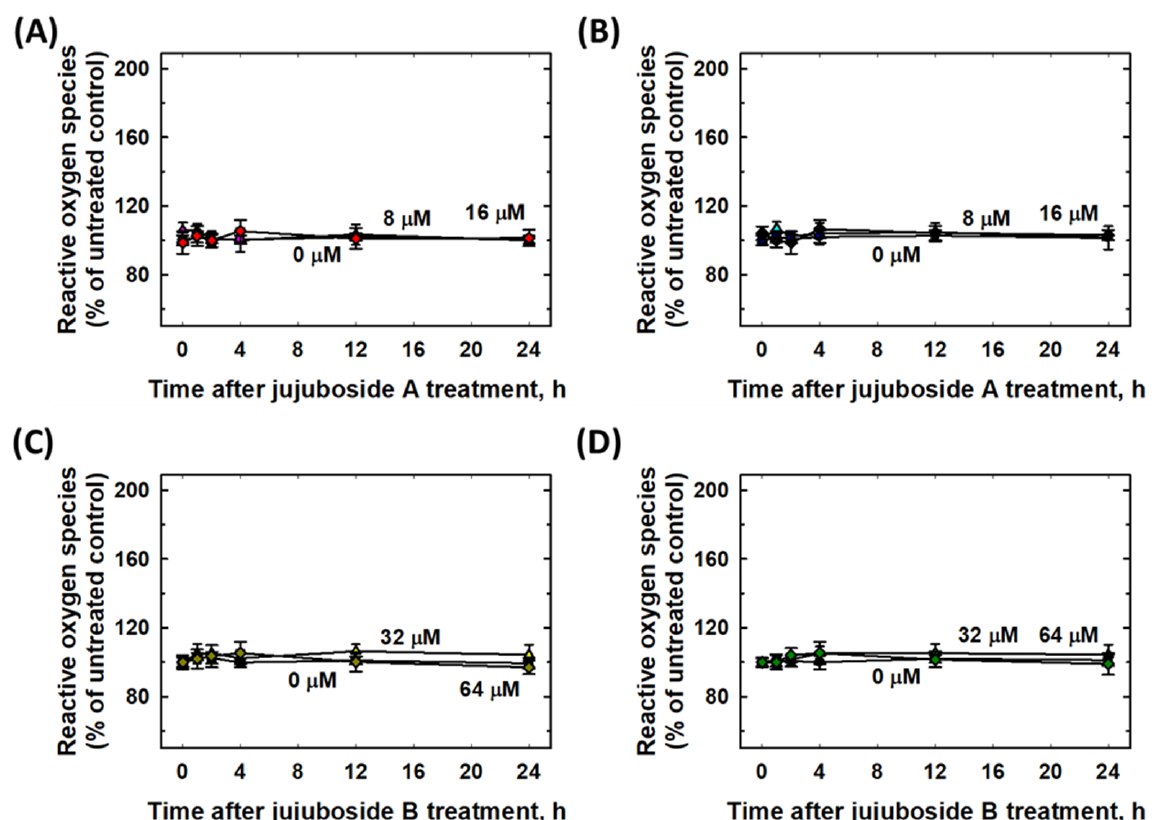
Figure 7. Effects of jujuboside A and B on intracellular reactive oxygen species (ROS) in SH-SY5Y and SK-N-SH cells. ( A , B ) Effects of jujuboside A on intracellular ROS of SH-SY5Y and SK-N-SH cells, respectively. ( C , D ) Effects of jujuboside B on intracellular ROS of SH-SY5Y and SK-N-SH cells, respectively. Each experiment was repeated for at least 6 times.